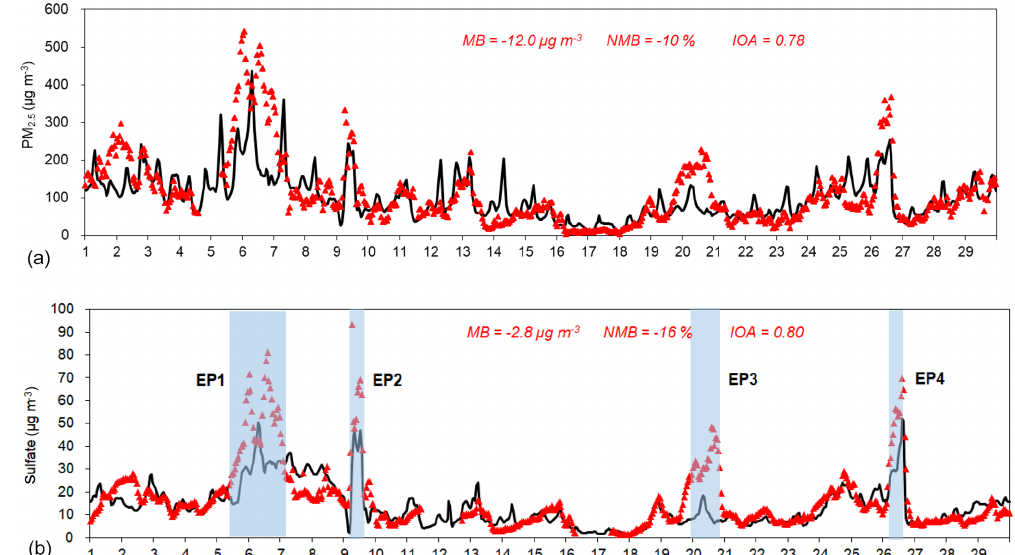
Figure 4. Simulated and observed PM 2 . 5 (a) and sulfate (b) concentrations (µgm − 3 ) at the SAES site during 1 to 29 December 2013.